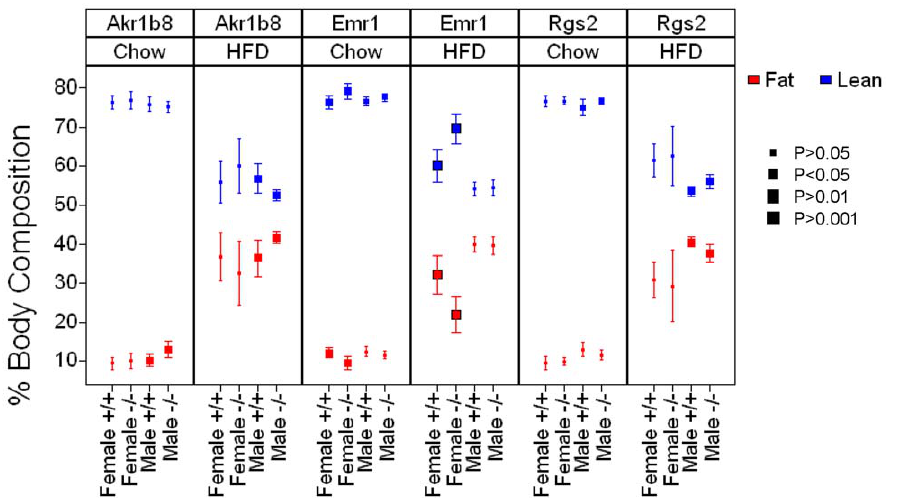
Figure 4. Body Composition by qNMR for Akr1b8 2 / 2 ,Emr1 2 / 2 and Rgs2 2 / 2 mice on chow and HFD. Body composition for Akr1b8, Emr1 and Rgs2 knockout and littermate control mice was assessed on chow diet (8–10 weeks of age) and after 9 weeks on HFD (17–23 weeks of age). Data points are averages with 95% confidence intervals. Statistically significant differences between genotypic groups split by gender are marked. All gender, genotype, diet groups were n=9 except for the female Emr1 + / + HFD fed and female Rgs2 2 / 2 chow fed groups were n=8.